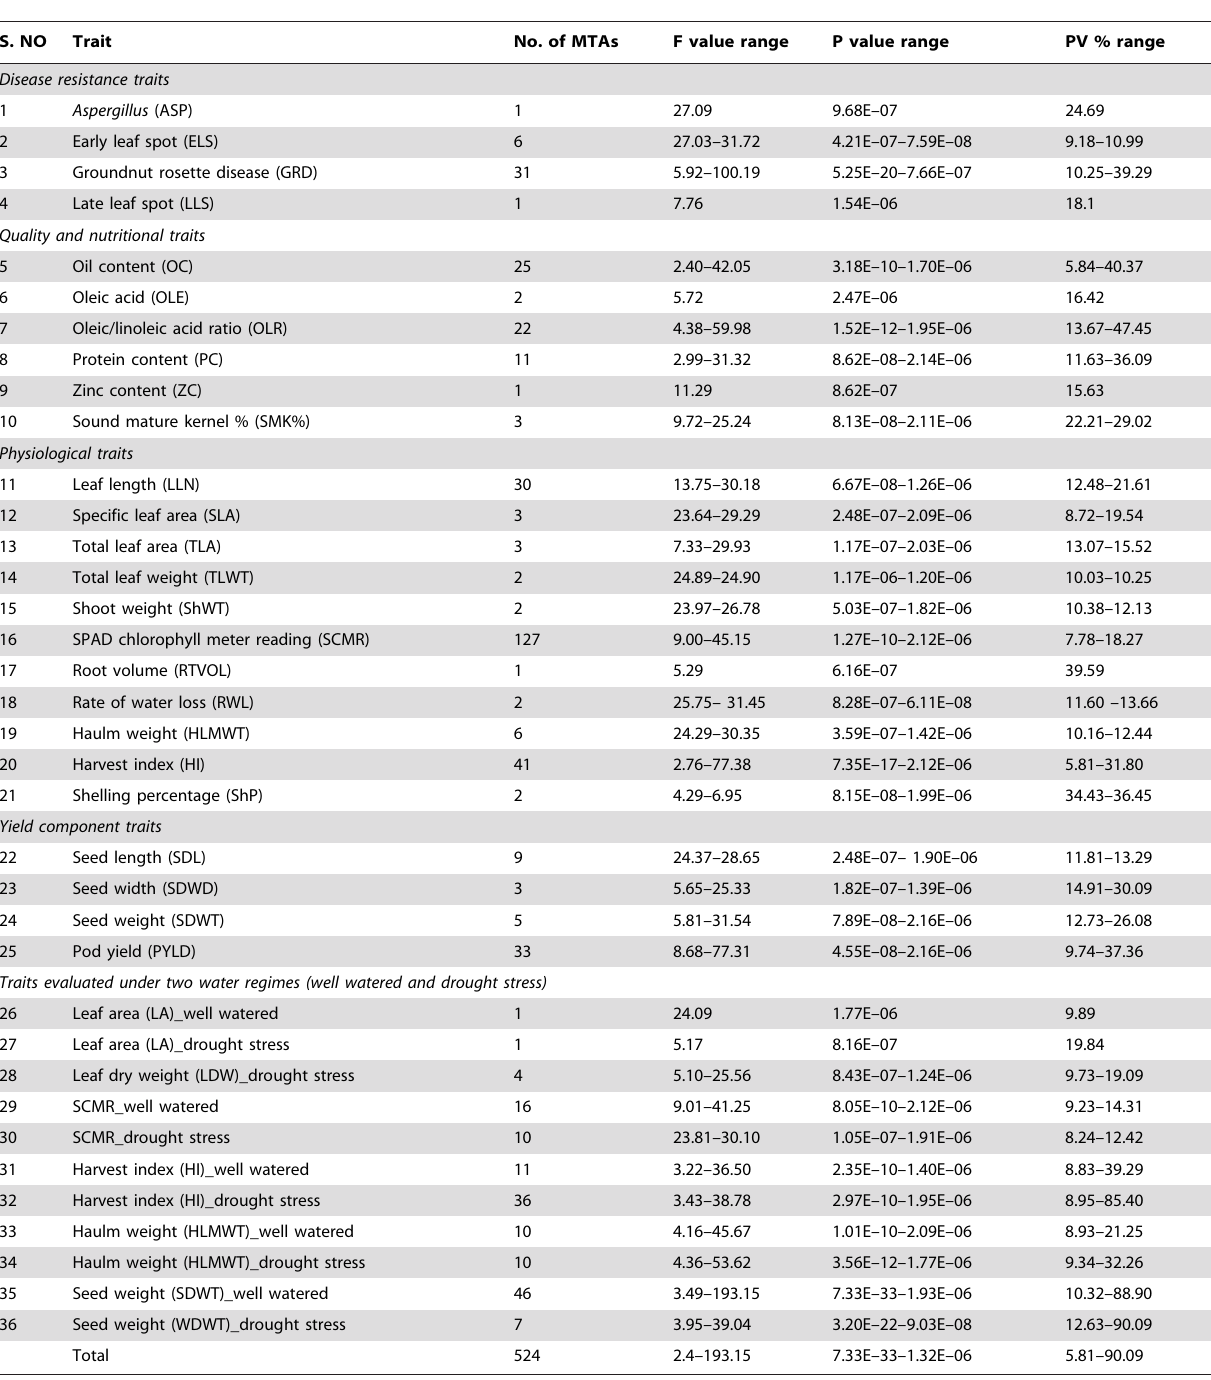
Table 1. Marker-trait associations (MTAs) identified for select agronomically important